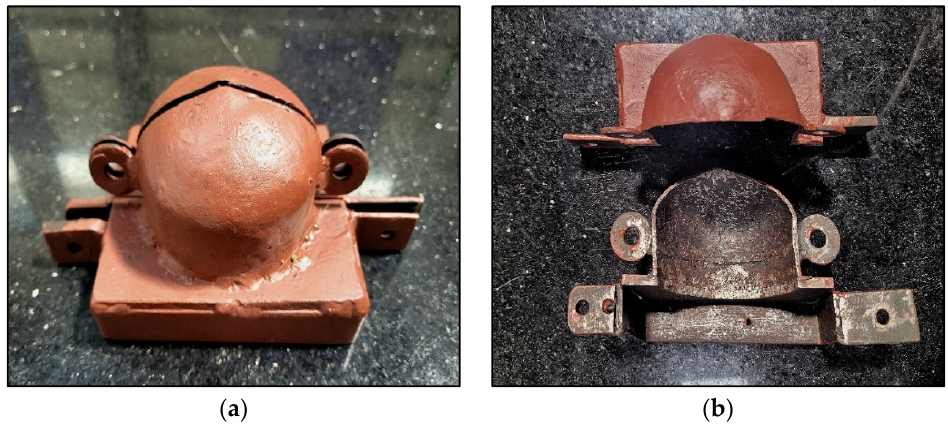
Figure 11. The dimensions of the scaled-down mimicked shape.